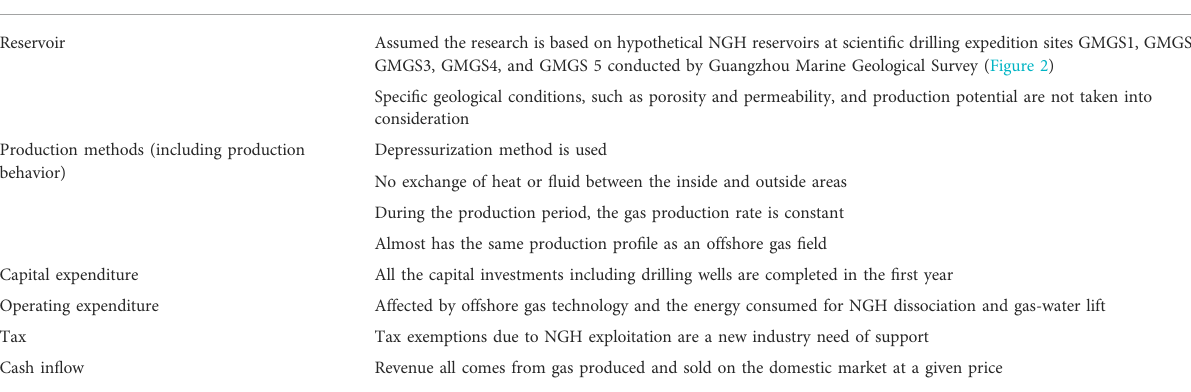
TABLE 1 Conditions/assumptions for economic evaluation.